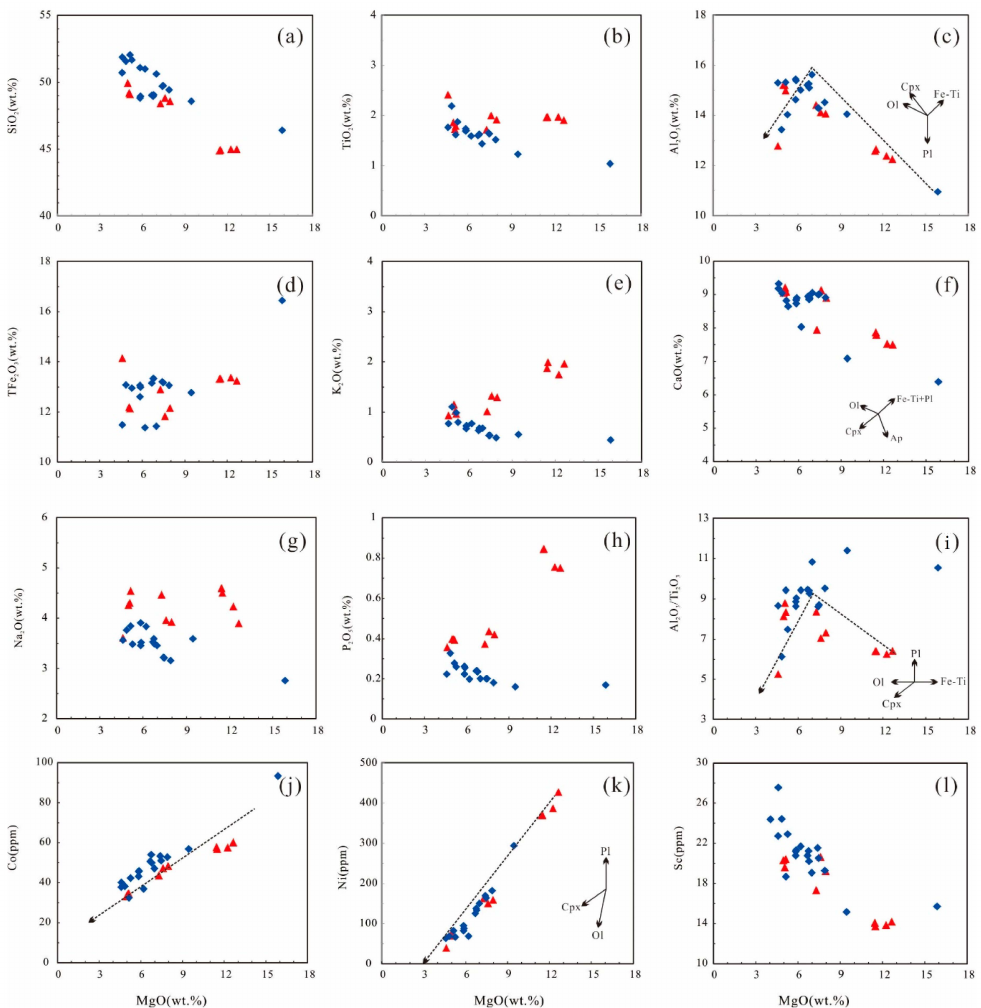
Figure 7. MgO versus major ( a – i ) and trace elements ( j – l ) of the Cenozoic mafic rocks in the Qianjiadian